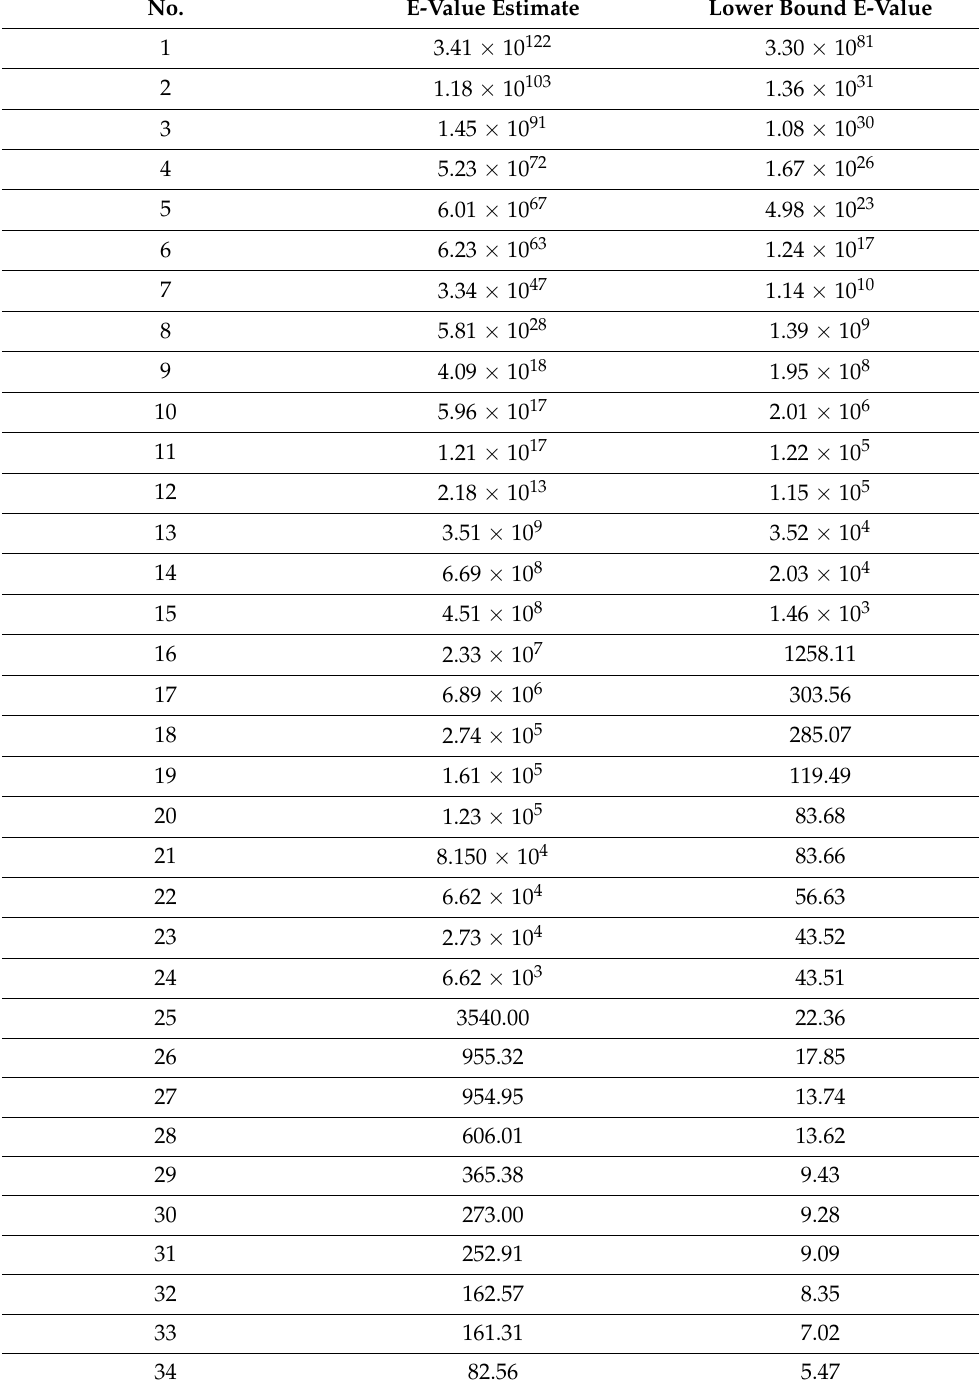
The E-values may be extracted alone and listed and ordered as shown in Table 10. Here, it is noted that 45/51 (88.2%) E-value estimates exceed 9 and are thus in the high range [110], and all 51/51 (100%) exceed the threshold of causality at 1.25 [109]. Moreover, 31/51 (60.8%) mEV’s exceed nine and therefore fall into the high range and 51/51 (100%) exceed the threshold for